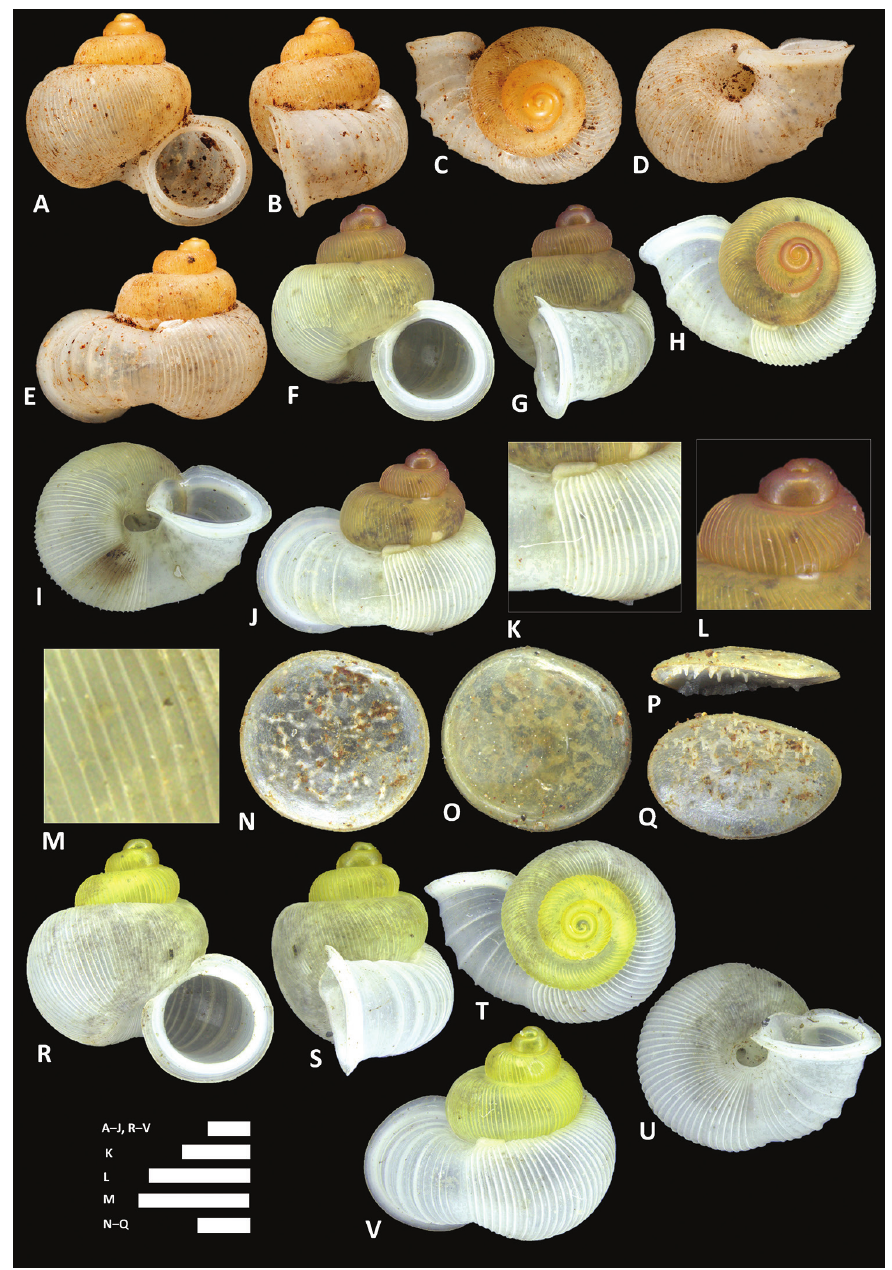
Figure 10. Alycaeus balingensis Tomlin, 1948. A–E Shell of syntype, NHMUK 1948.10.2.4 F–J Shell of BOR/MOL 8357 K–M Close up of shell of BOR/MOL 8357 N–Q Operculum of BOR/MOL 8357 R–V Shell of BOR/MOL 8361. Scale bars: A–J, R–V, K, L 1 mm; M, N–Q 0.5 mm. Photo- graphs A–E by NHM staff (copyright of NHM, reproduced with permission). Photographs F–V by Junn Kitt